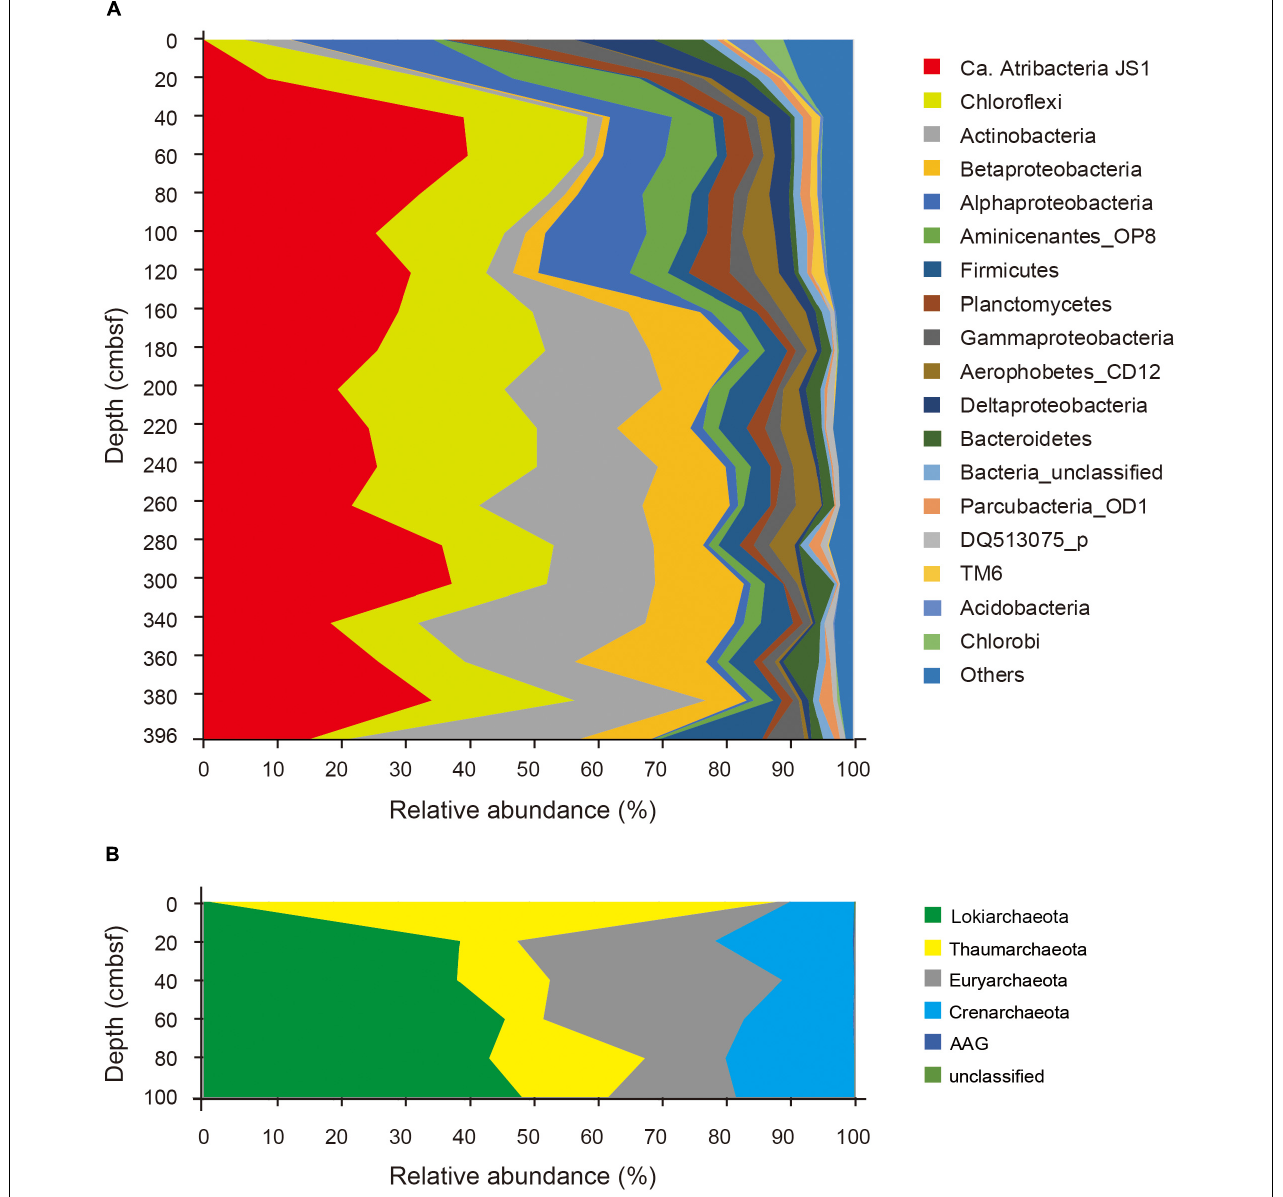
FIGURE 1 | Relative abundance of sequenced bacterial (A) and archaeal communities (B) at the phylum level or the class level in the case of Proteobacteria along the depth of the core.